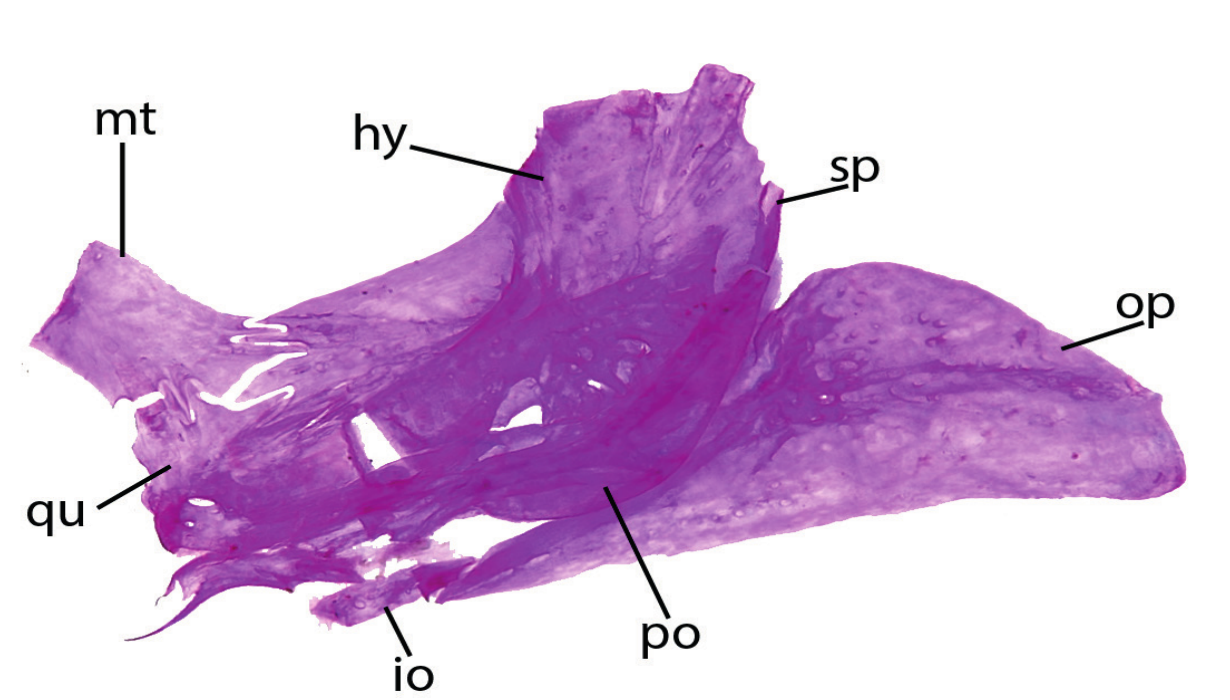
FIGURE 3 | Left suspensorium, lateral view, of Tatia akroa , UFOPA-I 670, 34.3 mm SL. Abbreviations: hy , hyomandibula; io , interopercle; mt , metapterygoid; op , opercle; po , preopercle; qu , quadrate; sp , suprapreopercle.